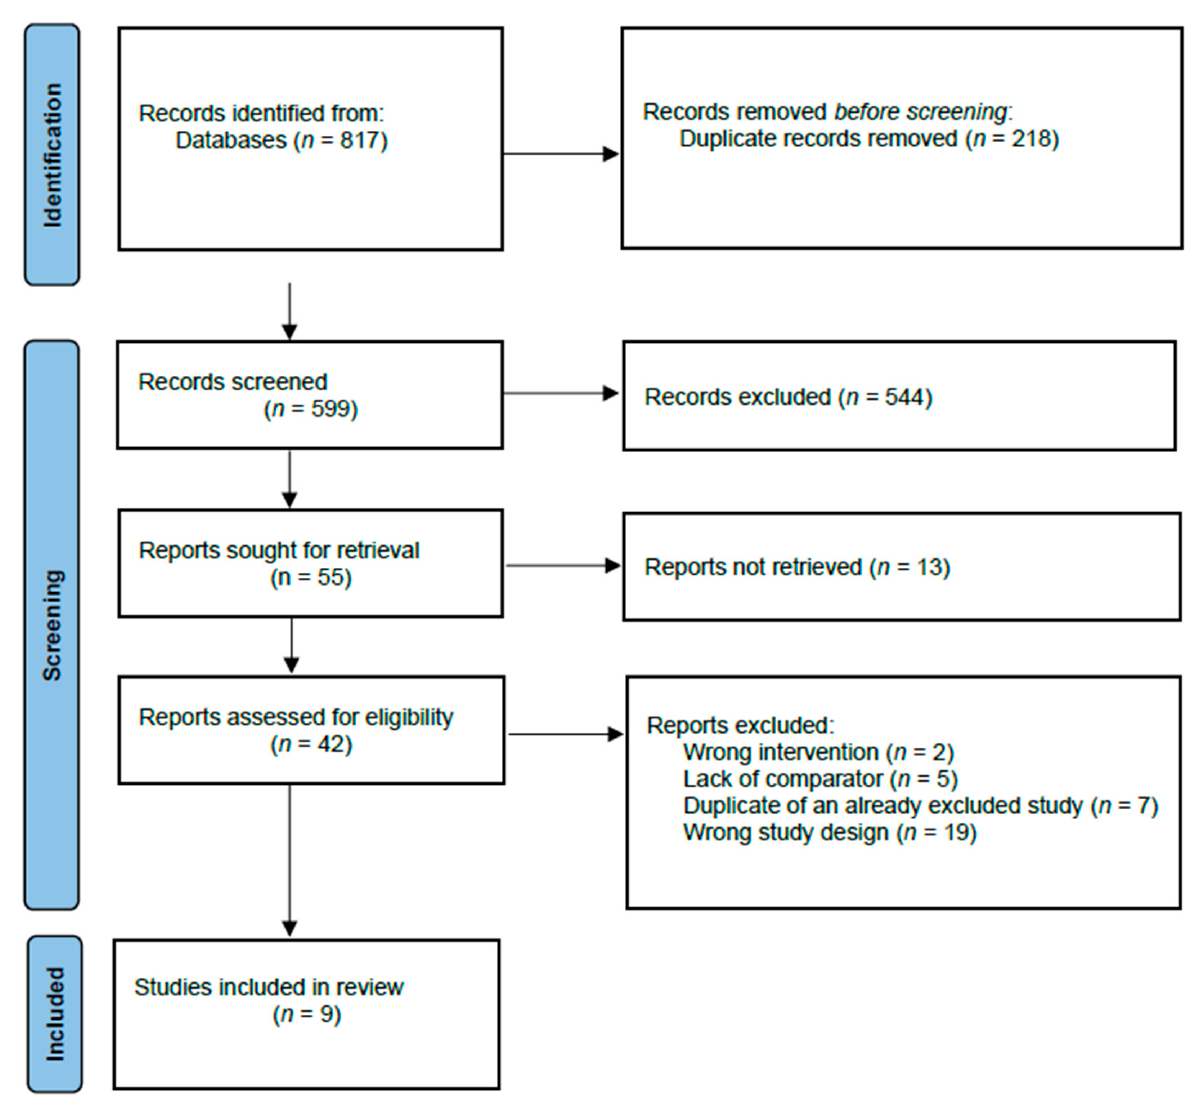
Figure 1. Identification of studies.